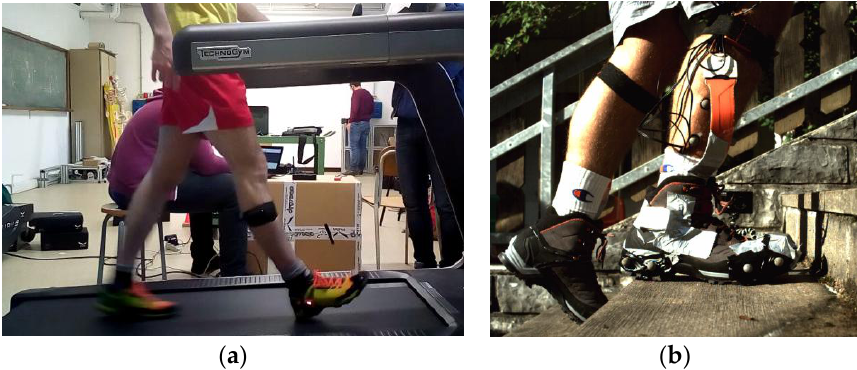
Figure 3. Data collection sessions: ( a ) example of data collection of one subject wearing TR shoes, walking at 5 km/h on a treadmill with an inclination of 5%; ( b ) example of data collection of one subject wearing CH shoes climbing a flight of stairs outdoor. Both IMU and video based acquisition systems were used